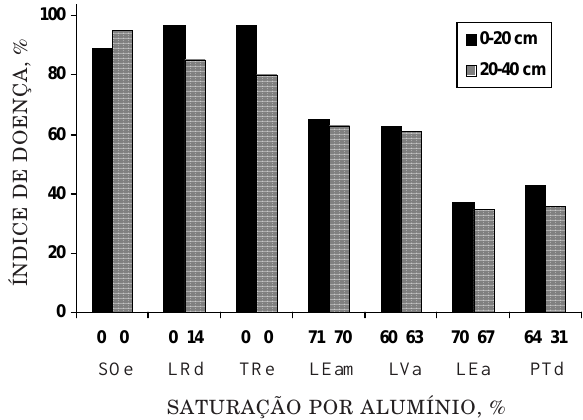
Figura 1. Relação entre a % de saturação por Al 3+ (m) e índice de doença (ID), em plântulas de soja desenvolvidas em materiais da camada superficial (0-20 cm) e subsuperficial (20-40 cm) de sete solos (médias originais obtidas de 3